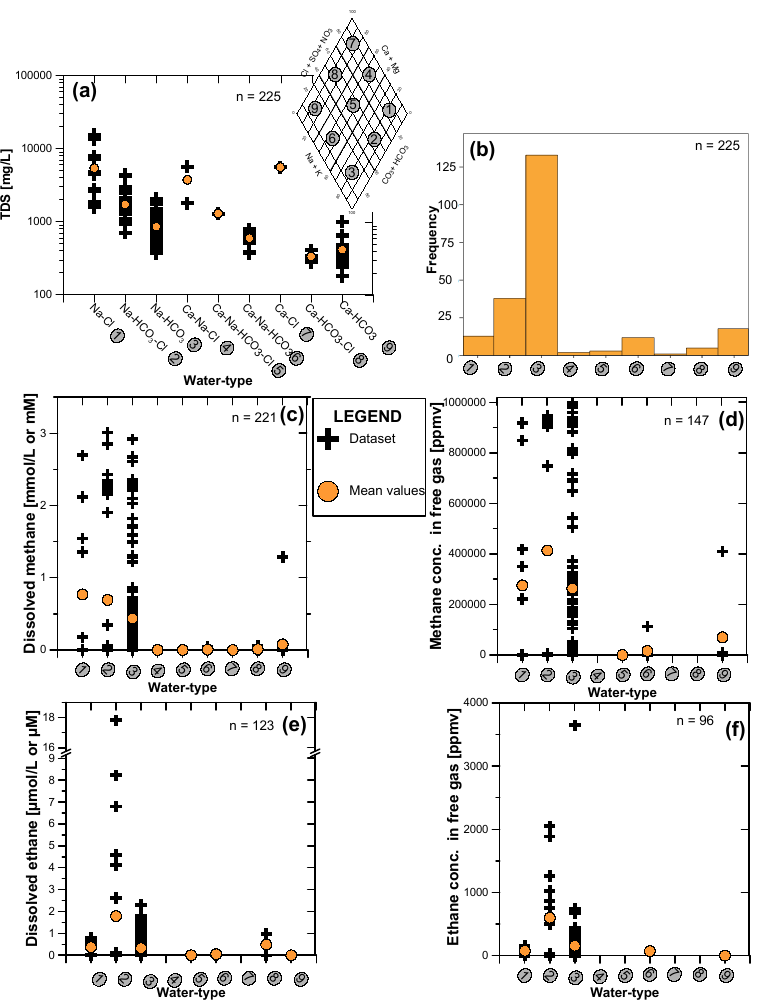
Figure 4. (a) Distribution of TDS (b) frequency histogram of methane-containing samples, methane, and ethane in both dissolved (c, e) and free gas (d, f) phases vs. water type classification defined in the Piper diagram.